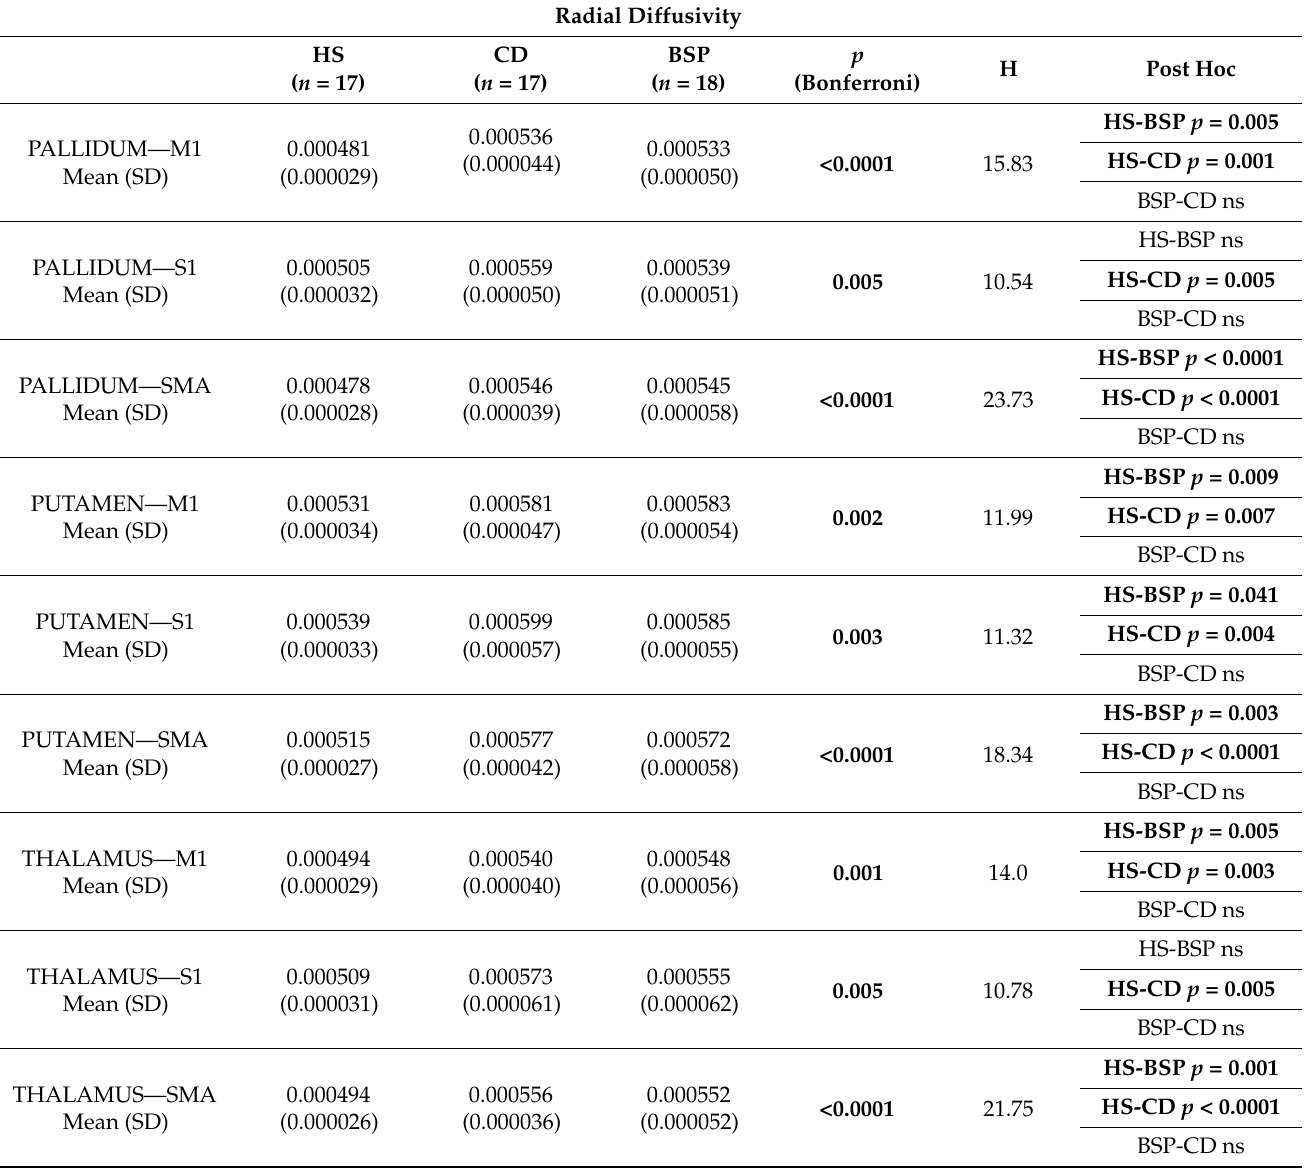
Table 5. Radial diffusivity of subcortical-cortical WM